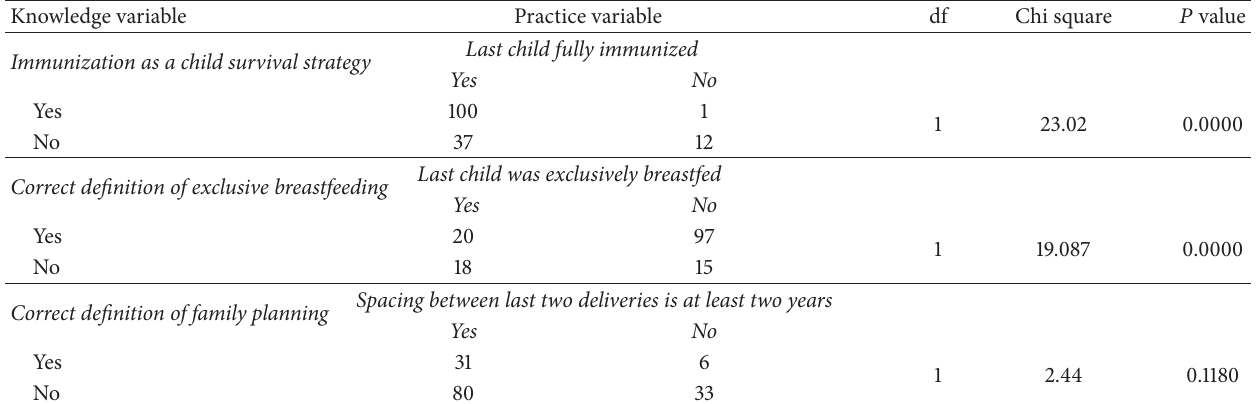
Table 8: Association between knowledge and practice of child survival